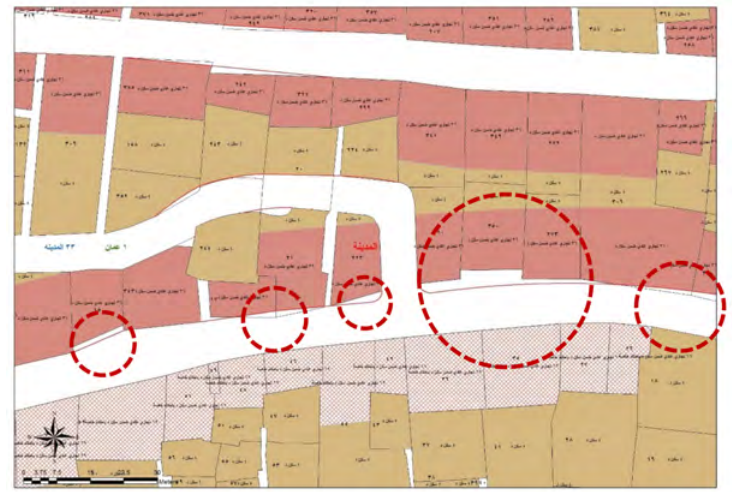
Figure 1. Land leftover land-use map. Source: GAM- GIS for the author (2016).